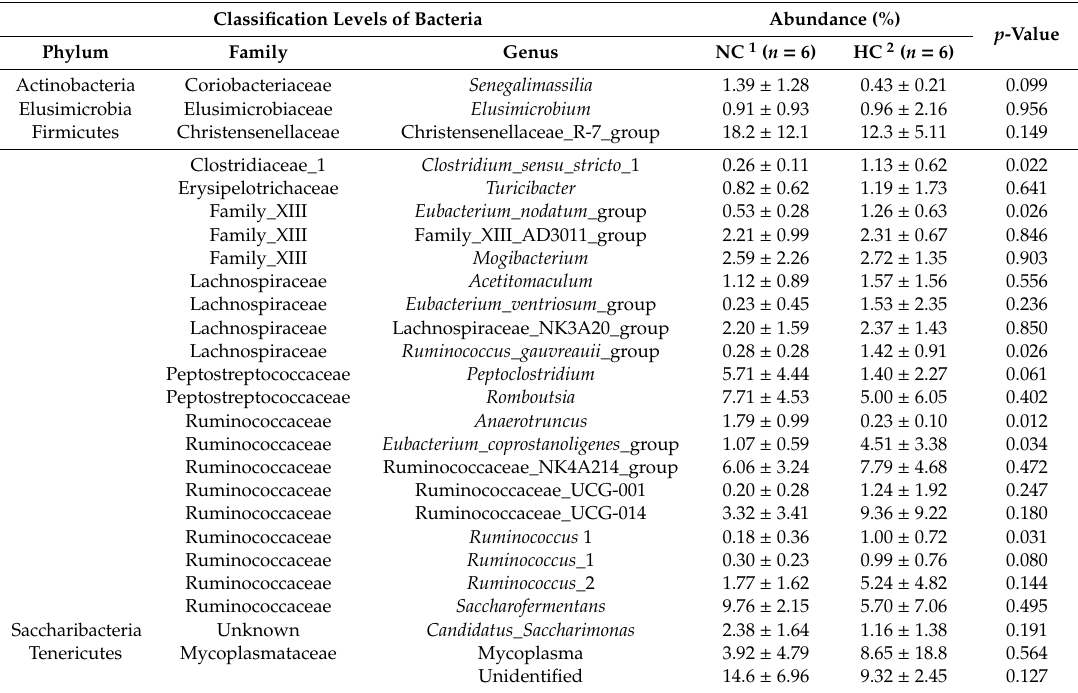
Table4. Genus-levelcompositionoftheilealbacterialcommunityoftwelvegoatsfednormal-concentrate (NC) and high-concentrate (HC)